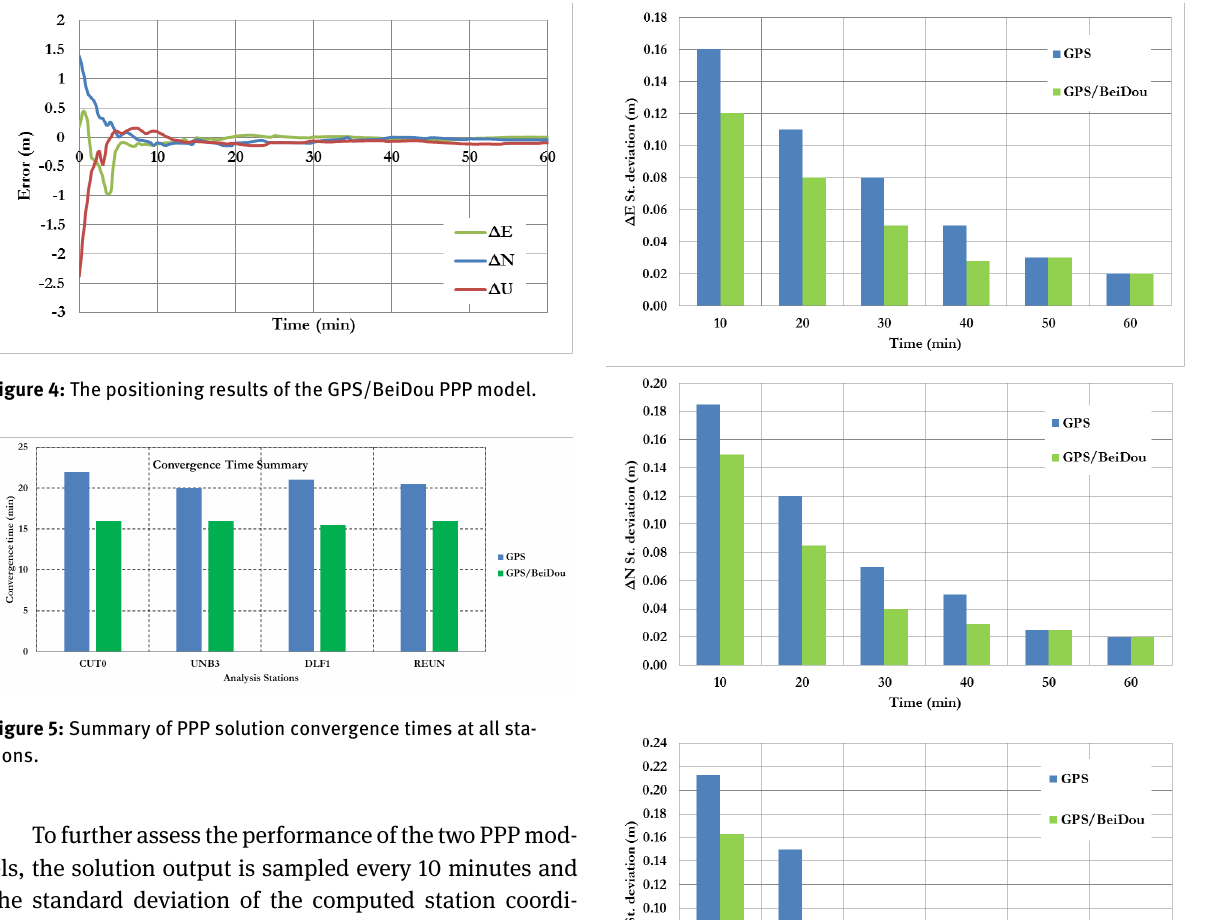
gence time of the combined GPS/BeiDou PPP solution is reduced by about 25% in comparison with the GPS-only